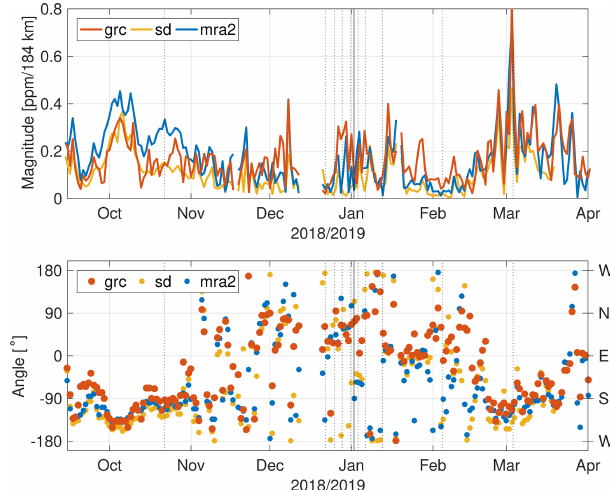
Figure 10. Magnitude and angle of the ozone gradients at 3hPa above Ny-Ålesund from GROMOS-C, SD-WACCM and MERRA- 2 data during winter 2018/2019. The dotted lines indicate the dates of the polar vortex snapshots in Fig. 6 and the solid line shows the central date of the SSW. The cardinal directions which correspond to an angle are indicated on the